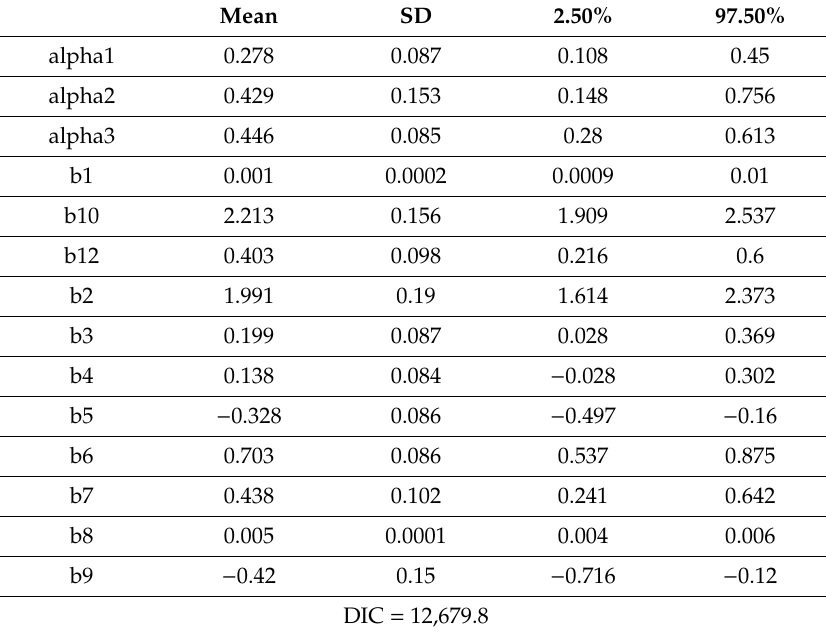
Table 4. Estimation results of single-layer model, with NB